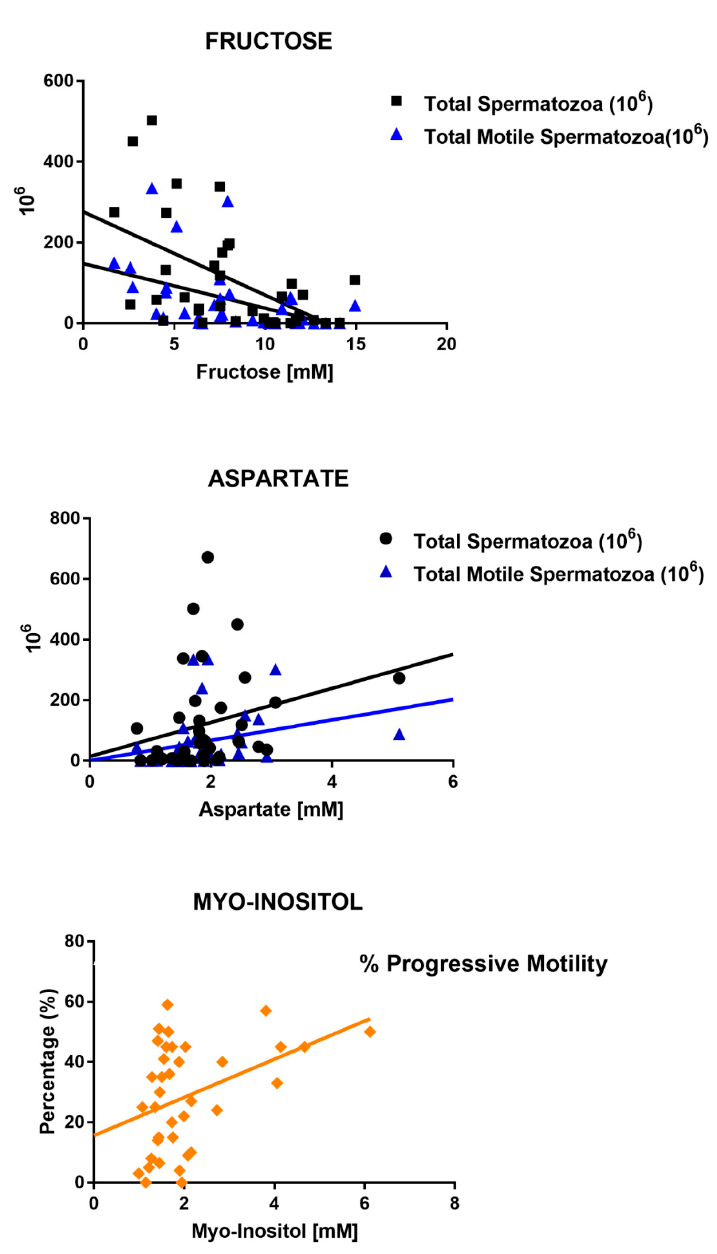
Figure 5. Plots showing a correlation between the different metabolites tested, and the clinical parameters of the patients: total spermatozoa, total motile spermatozoa, % of motility of spermatozoa, % of progressive motility having p -value < 0.05. Spearman correlation was used.